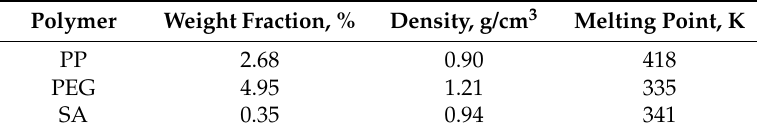
Table 2. Characteristics of polymer binders used in the present study.